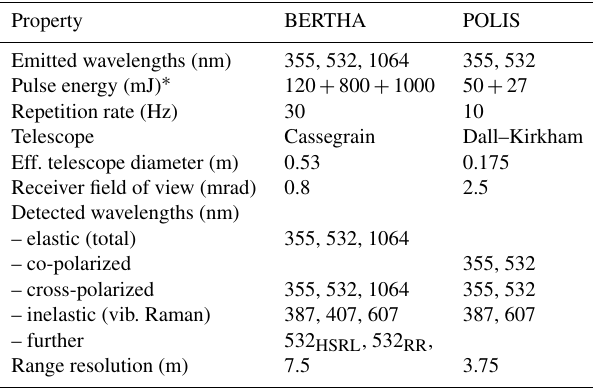
Table 1. Main system parameters of the BERTHA and POLIS lidar